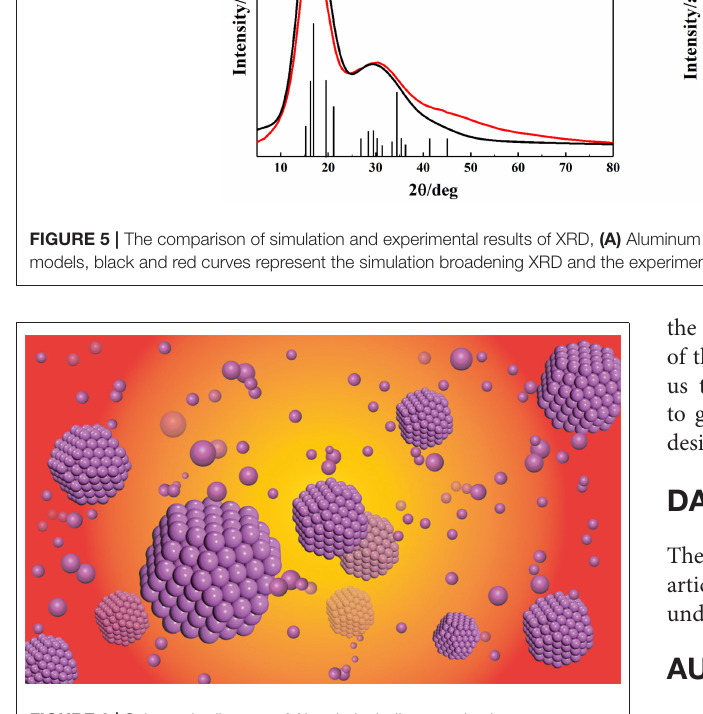
FIGURE 6 | Schematic diagram of Al melt, including atomic cluster structures and free